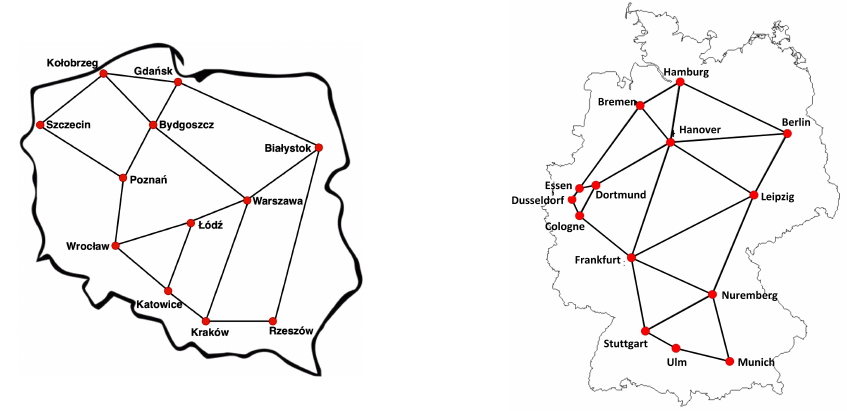
Figure 2. Examined network topologies: PL12 ( left ) and DT14 ( right